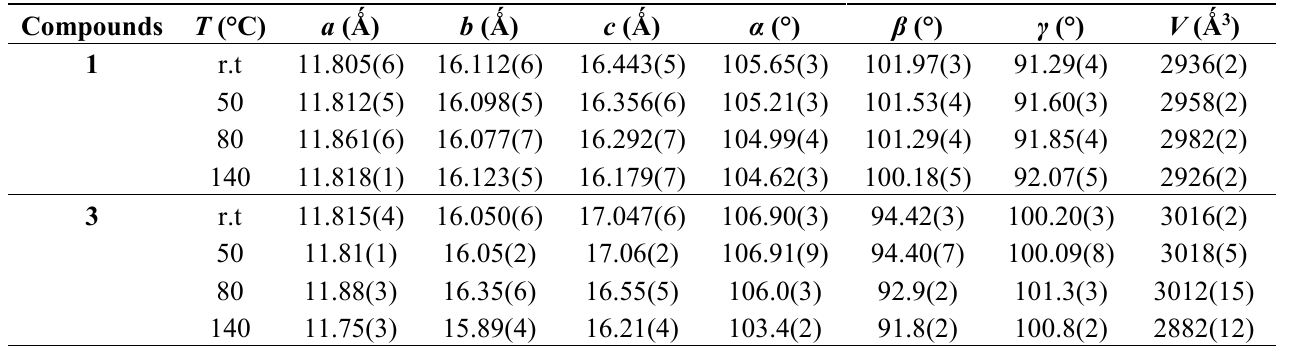
Figure 7. Photographs of single crystals of 1 taken at room temperature (left) and upon dehydration at 140 °C (right). Insets: images of the crystals used for performing the full single-crystal X-ray diffraction data collections of compouunds 1 and 1a . Table 2. Unit cell parameters of 1 and 3 at different